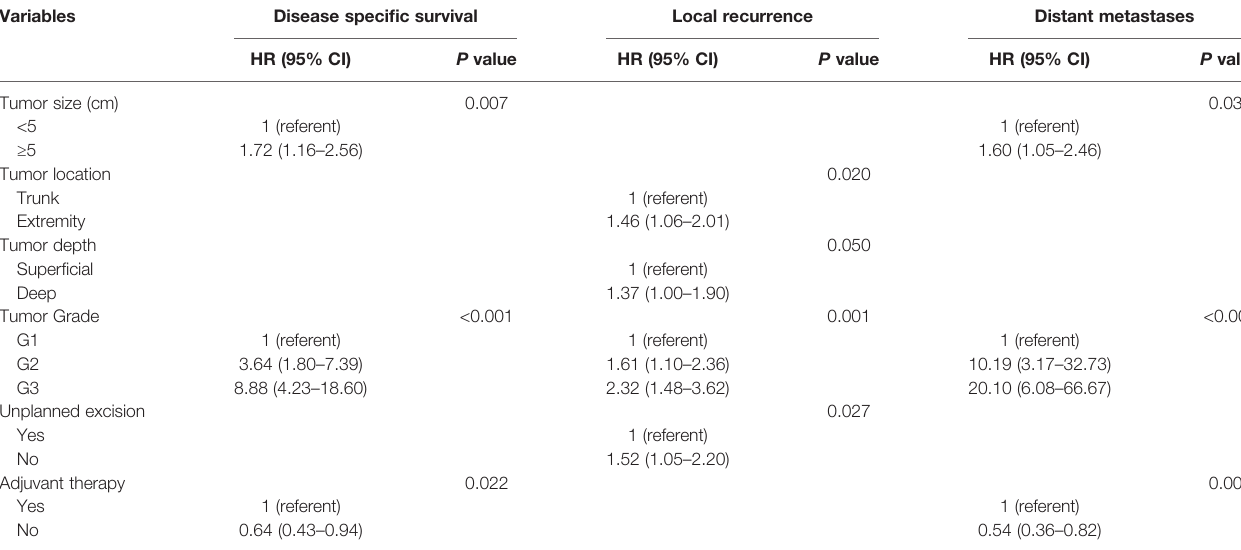
TABLE 4 | Multivariate analyses of variables for disease speci fi c survival, local recurrence and distant metastases (unmatched complete datasets).